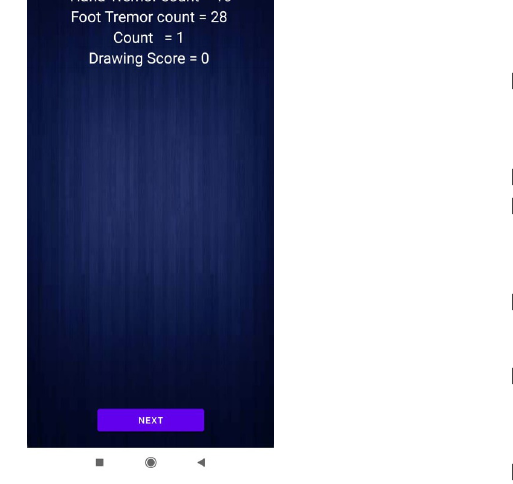
Figure 1: RESULTS OF THE TASK